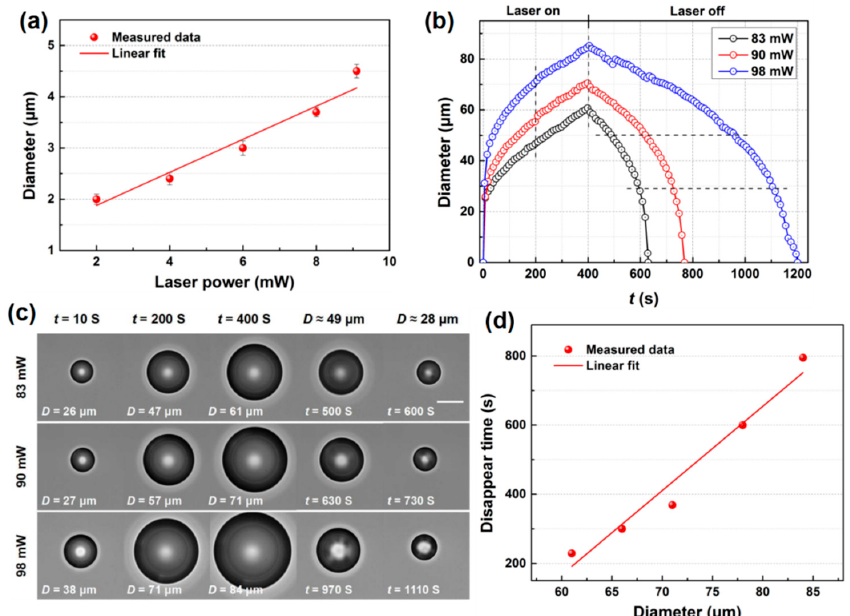
Figure 2. ( a ) The dependent relationship of the microbubble diameter with the laser power. ( b ) Evolution of expanding bubbles at laser powers of 83, 90, and 98 mW ( c ). Frames showing expanding and collapsing velocities and microbubble diameter induced by different laser powers. Scale bar: 30 μ m ( d ). The dependent relationship of the time it took for a microbubble to disappear on the microbubble size ( n = 3).